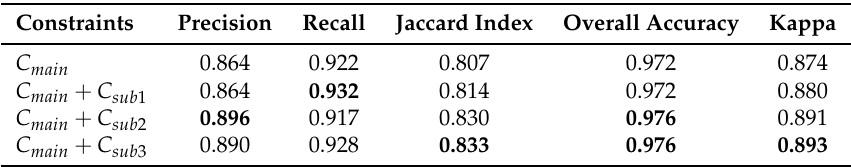
Table 7. Comparison of performance of MC–FCN models with different constraint combinations. The highest values for different metrics are highlighted in bold